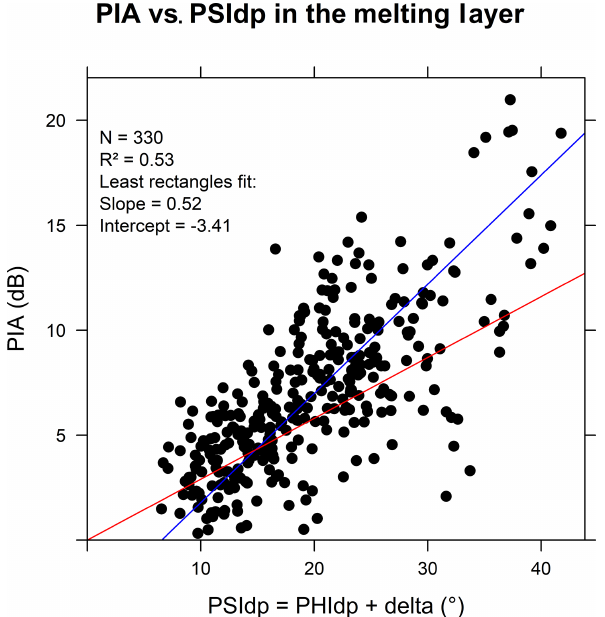
Figure 11. PIA– φ dp scatterplot in the ML for the stratiform event of 3–4 January 2018. The blue line corresponds to the least rectangle fit to the data, while the red line corresponds to the linear k – K dp relationship derived from the DSD data available at ground